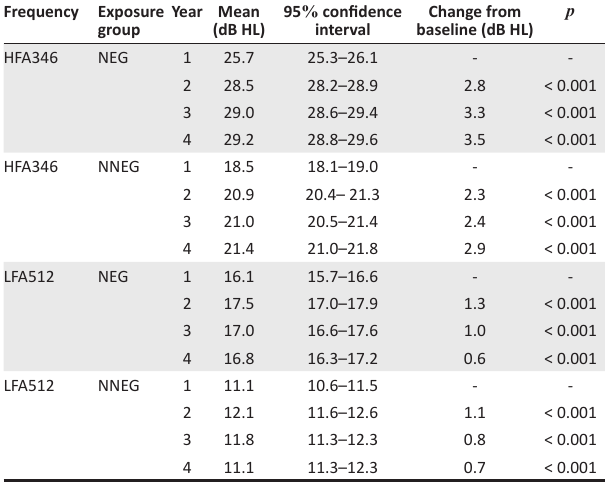
TABLE 2: Mixed-effects regression analysis of average hearing over the first four serial (yearly) audiograms for the non-noise exposed group and noise exposed group, adjusted for age. Frequency Exposure